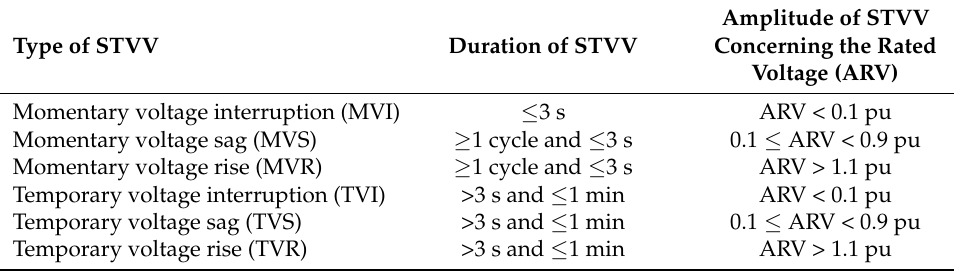
Table A11. Short-term voltage variations (STVV).